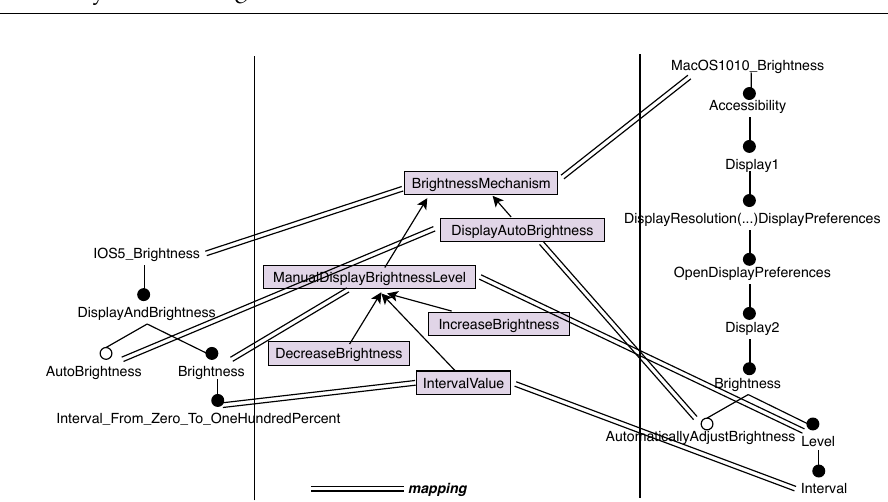
Figure 5. Mapping iOS 5 and MacOS 10.10 brightness to ontology.